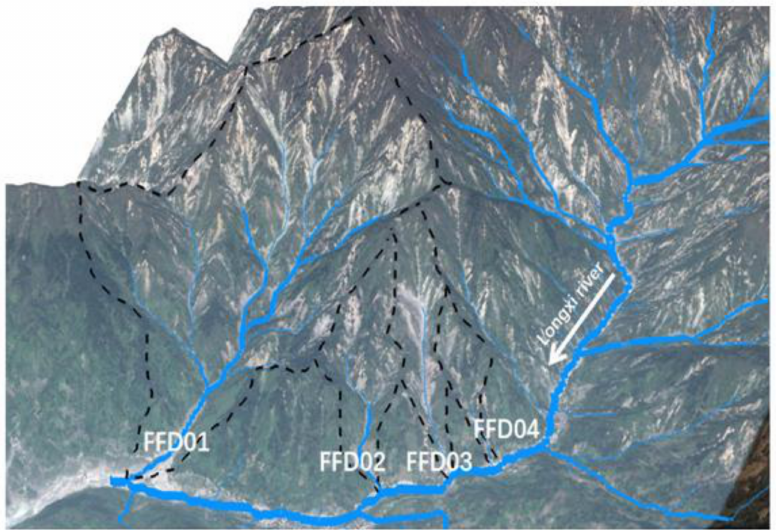
Figure 6. The location map of longxi river. (FFD01-Bayi gully, FFD02-Maliu gully, FFD03-Huangyang gully, FFD04-Shuida gully).